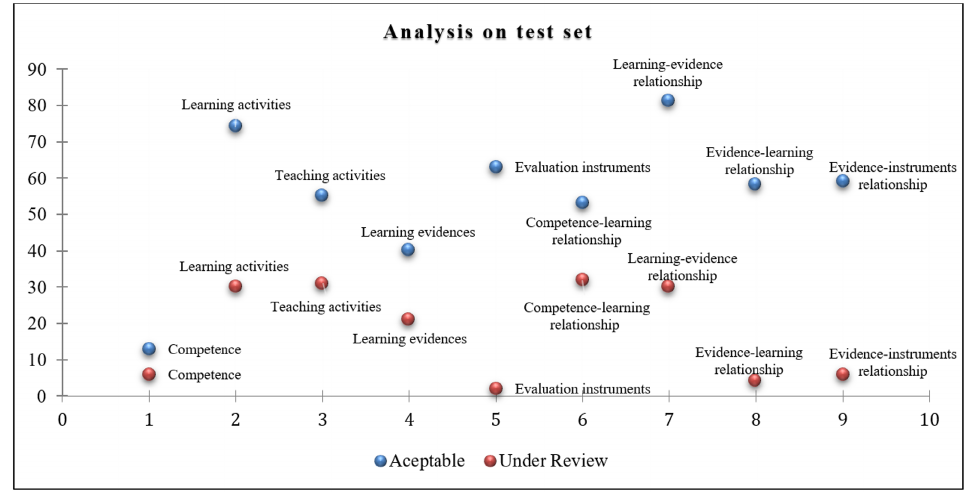
Figure 11. Analysis on test